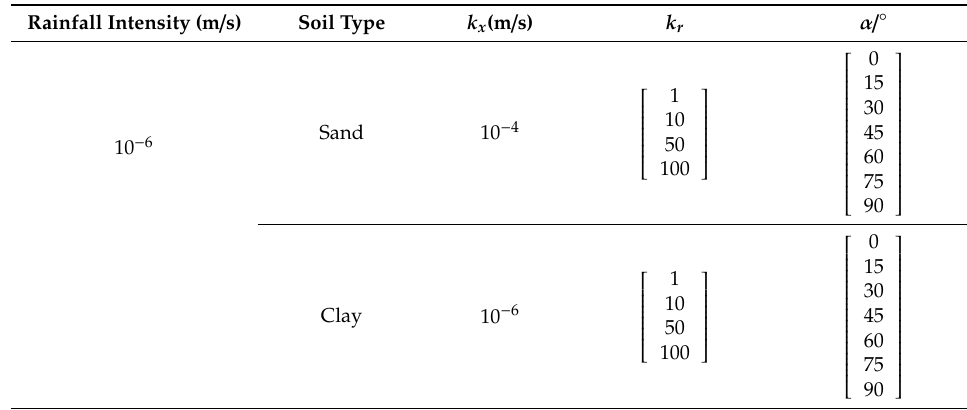
Table 2. Di ff erent calculation conditions.